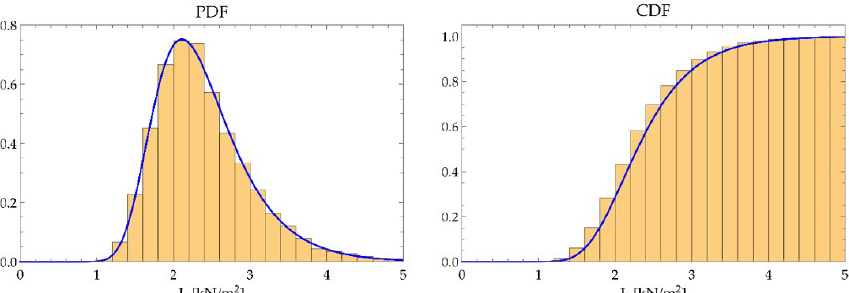
in an office floor with 𝐿𝐿 50